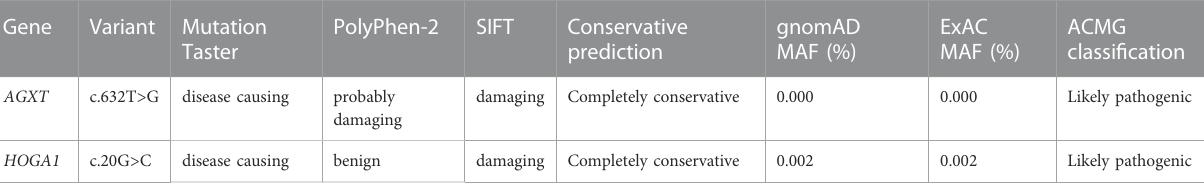
TABLE 2 Prediction of the pathogenicity of the novel missense variants.